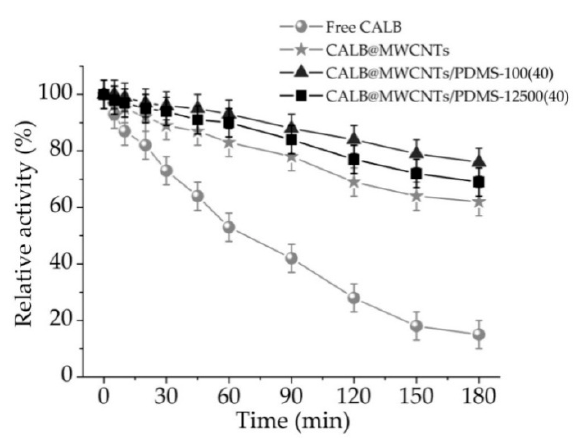
Figure 6. Thermal stability of free lipase and enzyme immobilized onto P-MWCNTs and MWCNTs/PDMS nanocomposites. Table 2. Inactivation constant and half-life of free lipase and enzyme immobilized onto P-MWCNTs and MWCNTs/PDMS nanocomposites.